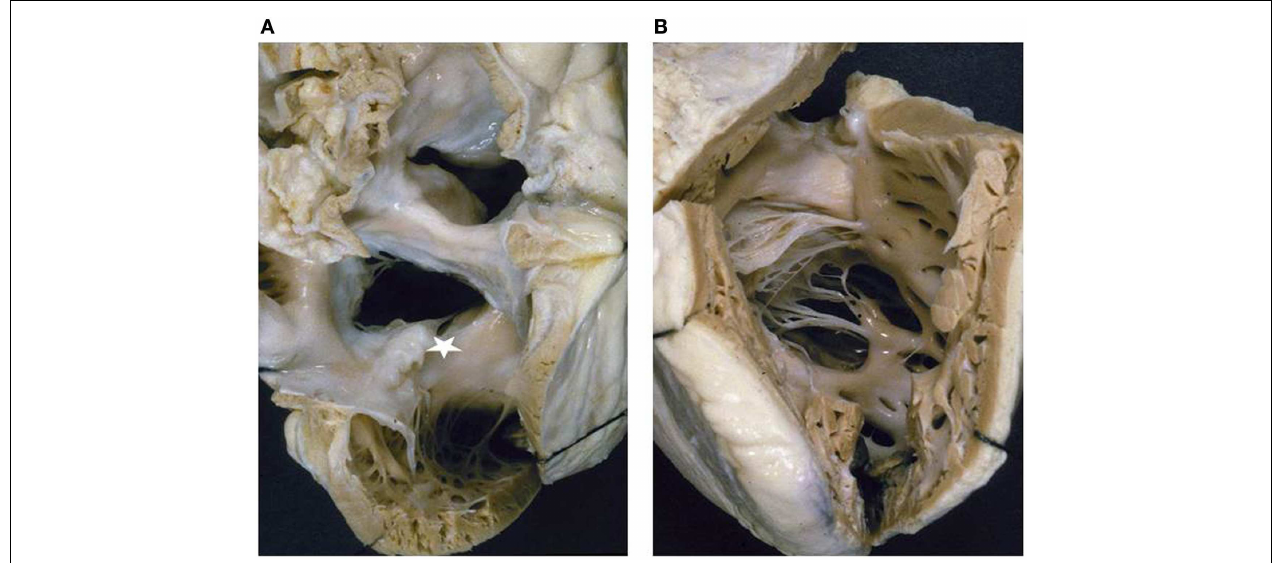
FIGURE 5 | Double inlet–outlet right ventricle . (A) View from the atria: both the atria drain mostly into a main ventricular chamber of right morphology through two separate atrioventricular valves.The left atrioventricular valve straddles and overrides the interventricular septum (star): note the posterior small ventricular chamber of left morphology. (B) View of the large right ventricle with coarse trabeculations in which both the atrioventricular valves drain.